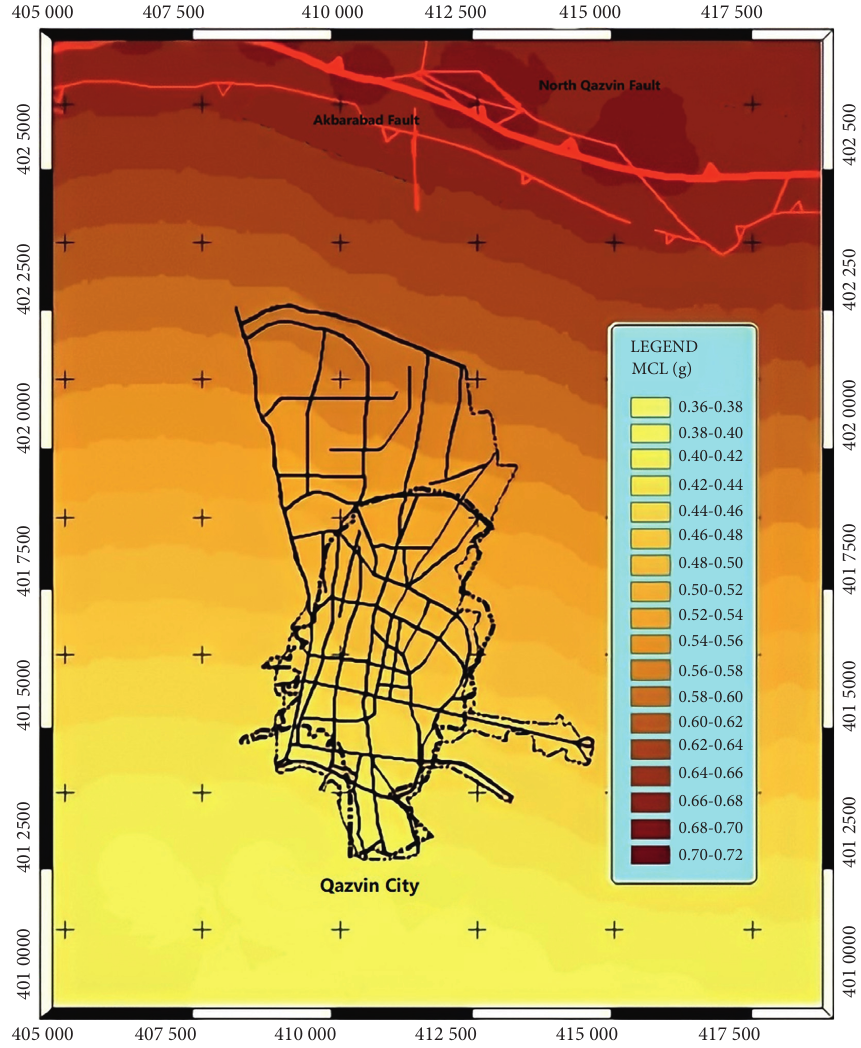
Figure 5: MCL Contour Map of Qazvin city